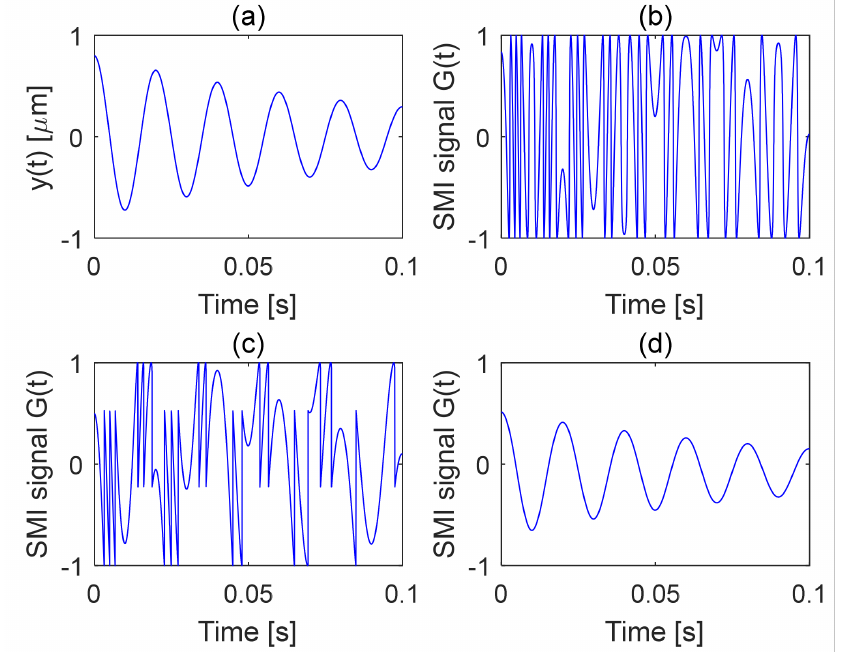
Figure 3. SMI signal with different optical feedback factors: ( a ) the initial vibration; ( b – d ) SMI signal with C = 0.8, C = 3.0, C = 20.0,